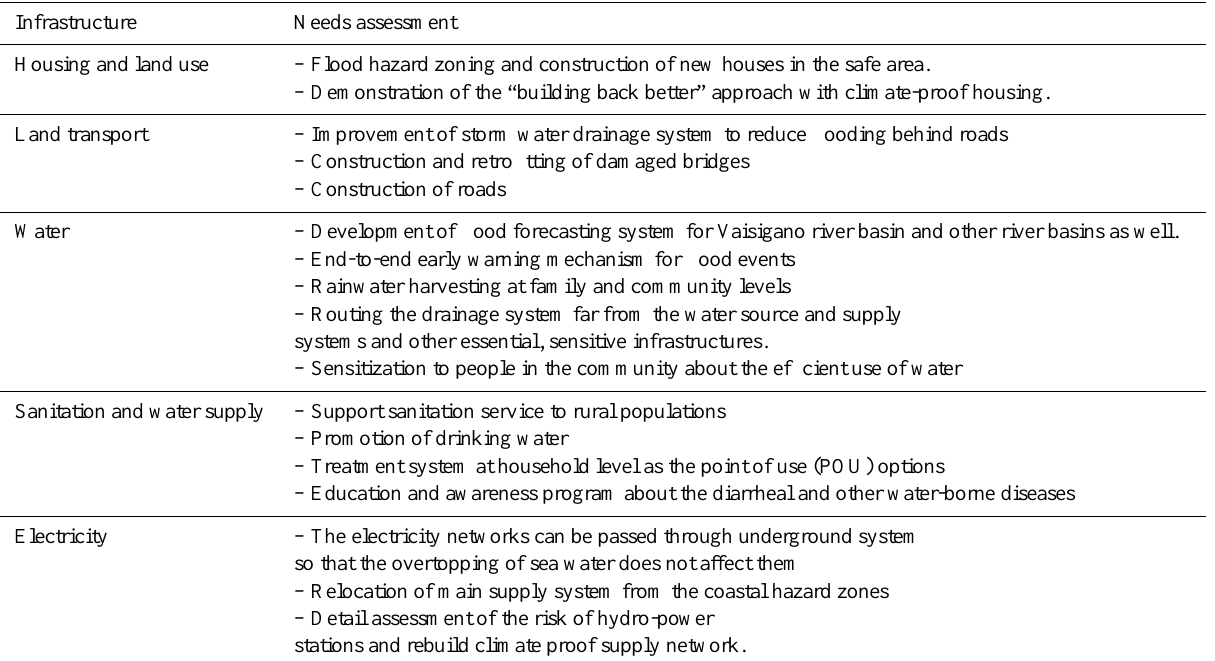
Table 4. Infrastructure needs assessment by